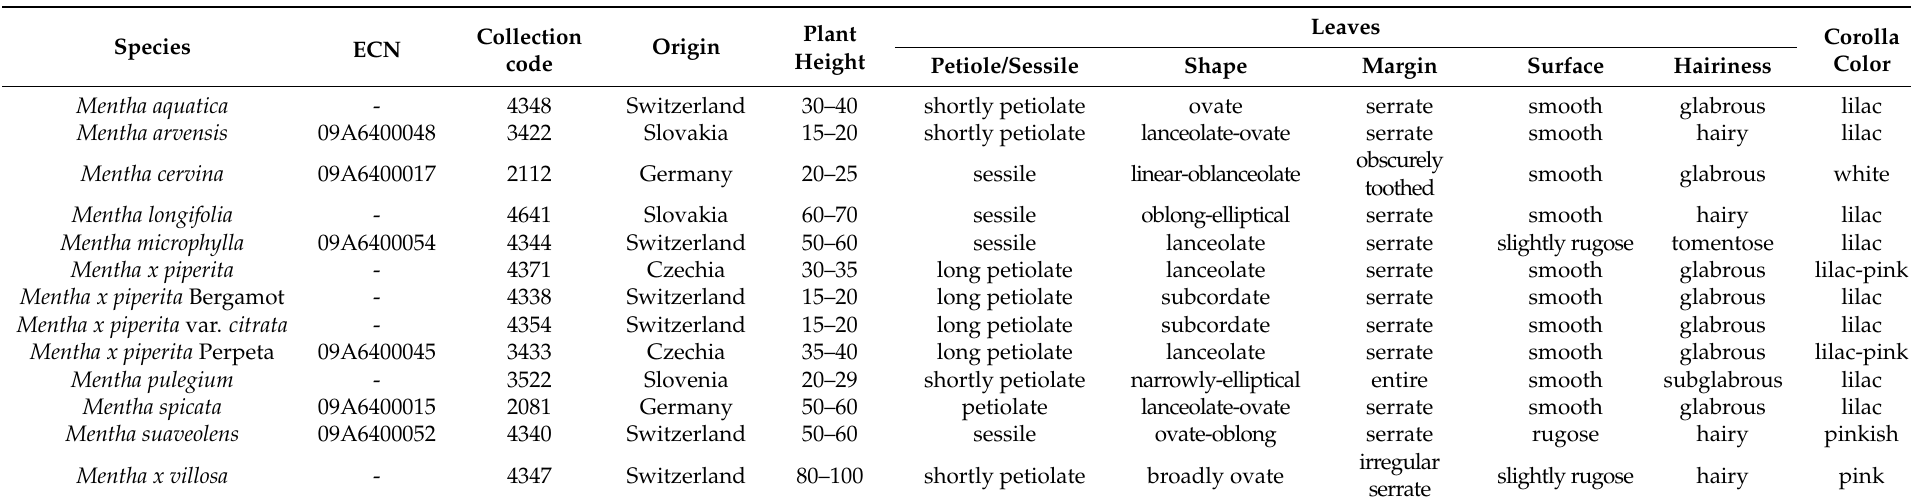
Table 3. Morphological characteristics of studied Mentha